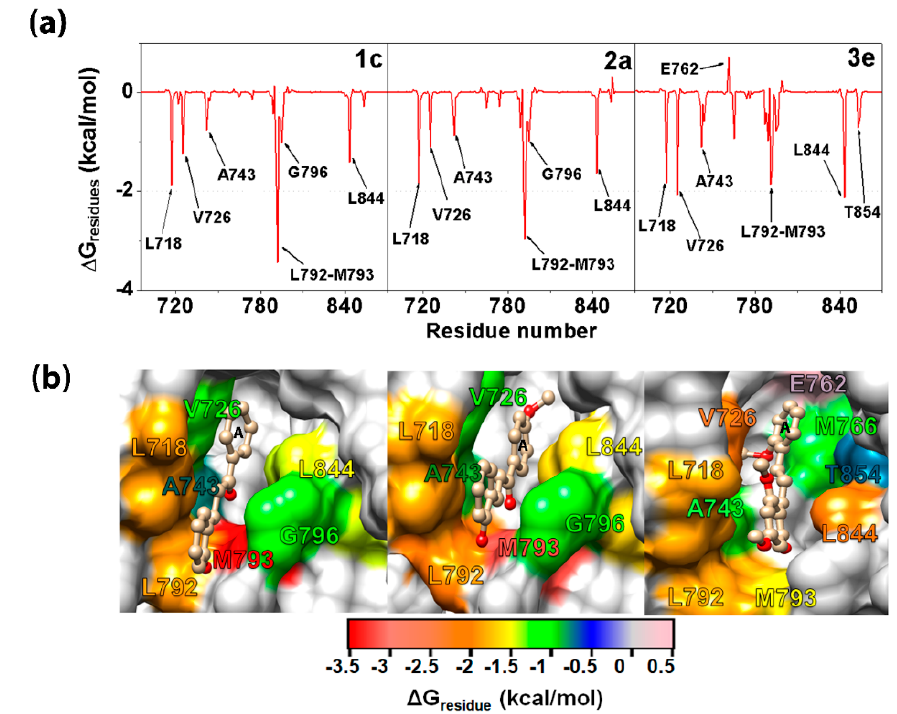
Figure 4. ( A ) Per-residue decomposition free energy of the three chalcone/EGFR-TK complexes and ( B ) their binding orientation inside the ATP-binding pocket of the TK domain drawn from the last MD snapshot, where the energy contour of residue contribution for ligand binding is shaded.